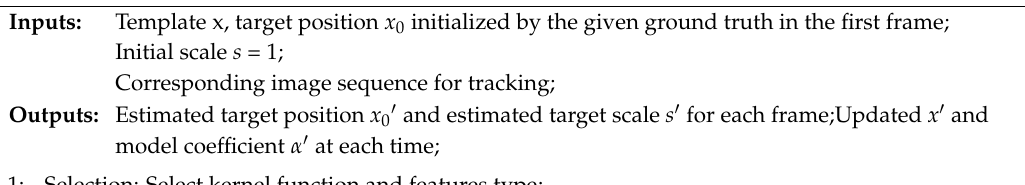
Algorithm 2. The Blur KCF